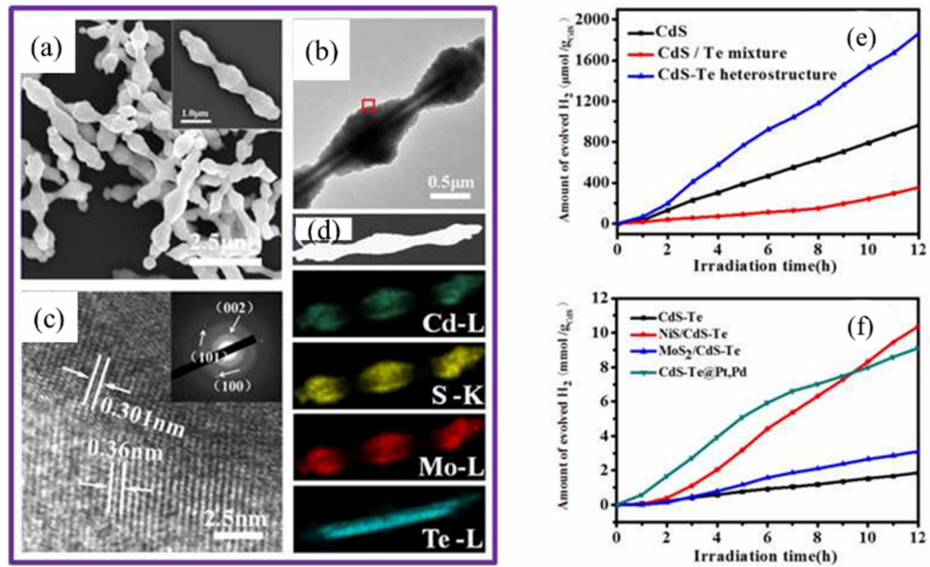
Figure 13. ( a – d ) MoS 2 /CdS-Te sample characterized with ( a ) SEM, ( b ) TEM, ( c ) HRTEM of the area marked with a square in ( b ) (the inset showing the corresponding SAED pattern), and ( d ) STEMEDS elemental mapping, showing the Cd (celadon), S (yellow), Mo (red), and Te (wathet). ( e , f ) Comparison of the photocatalytic activities of ( e ) CdS, CdS/Te mixture, and CdS-Te heterostructure, respectively; and ( f ) CdS-Te, NiS/CdS-Te, MoS 2 /CdS-Te and CdS-Te@Pt, Pd, respectively, in a lactic acid aqueous solution under visible light illumination. Reprinted with permission from [50]. Copyright 2015, American Chemical Society, Washington, DC, United